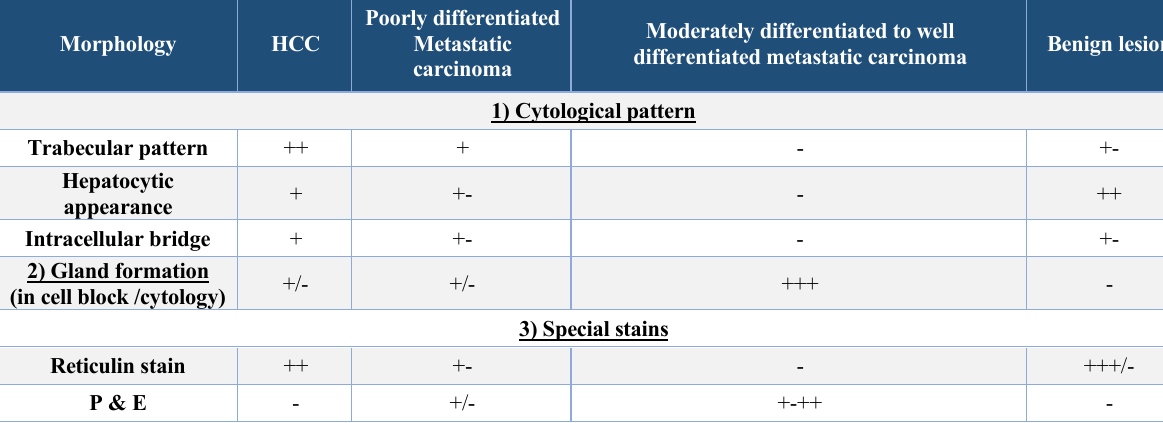
Table 3. IHC study on the liver